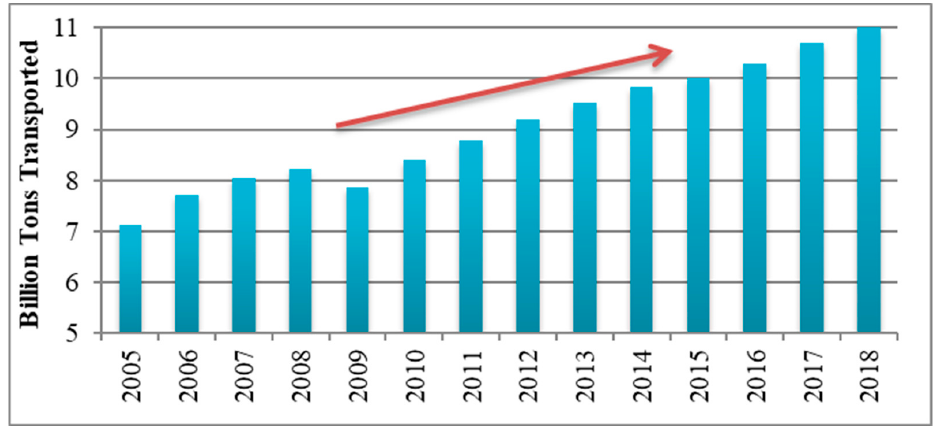
Figure 1. International waterborne trade volumes between 2005 and